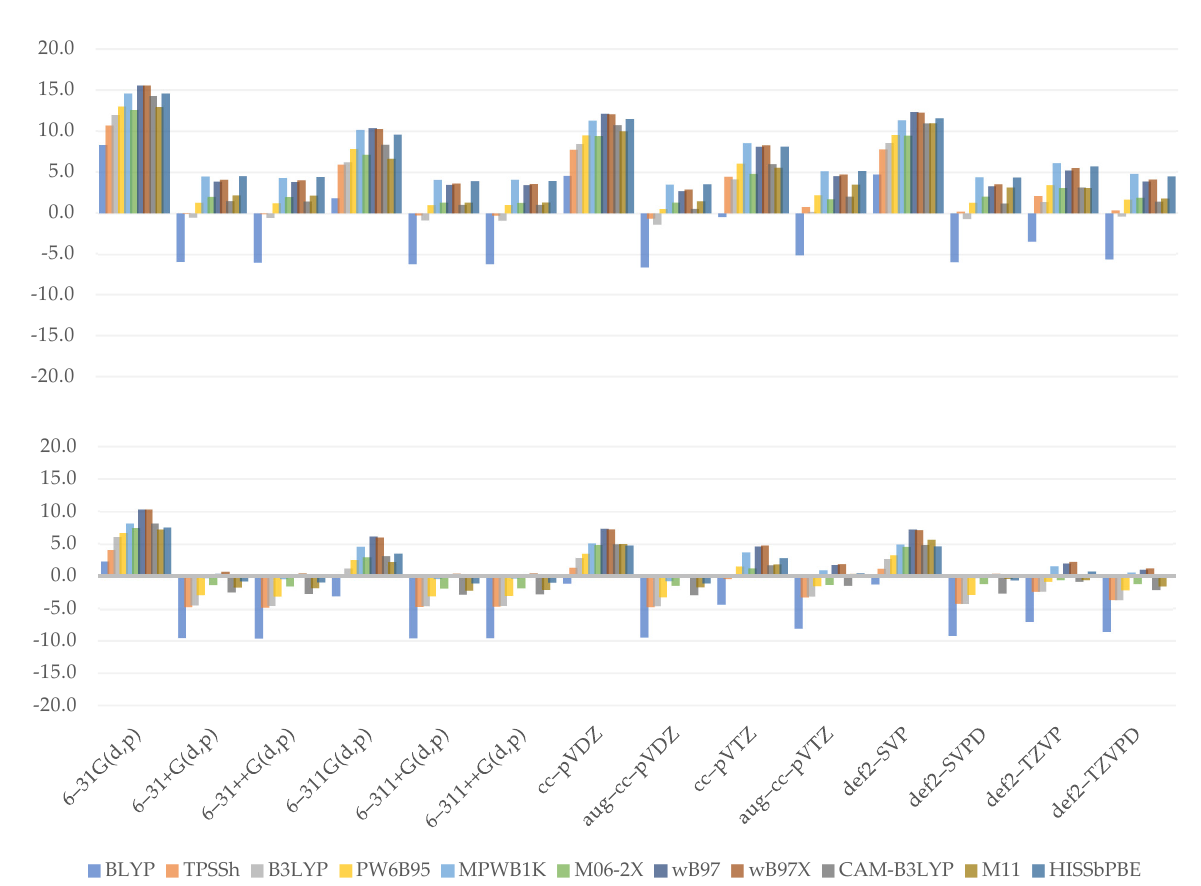
Figure 5. Relative errors to reference value for C3 ( upper ) and C4 ( lower ) hydroxyl proton affinity (kcal/mol).